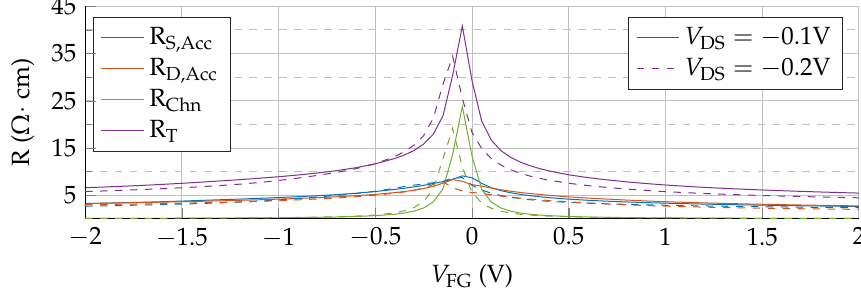
Figure 4. Resistance of the three device regions (channel, source and drain access regions) compared with the total resistance as a function of the gate potential, for two V DS values: − 0.1 V (solid) and − 0.2 V